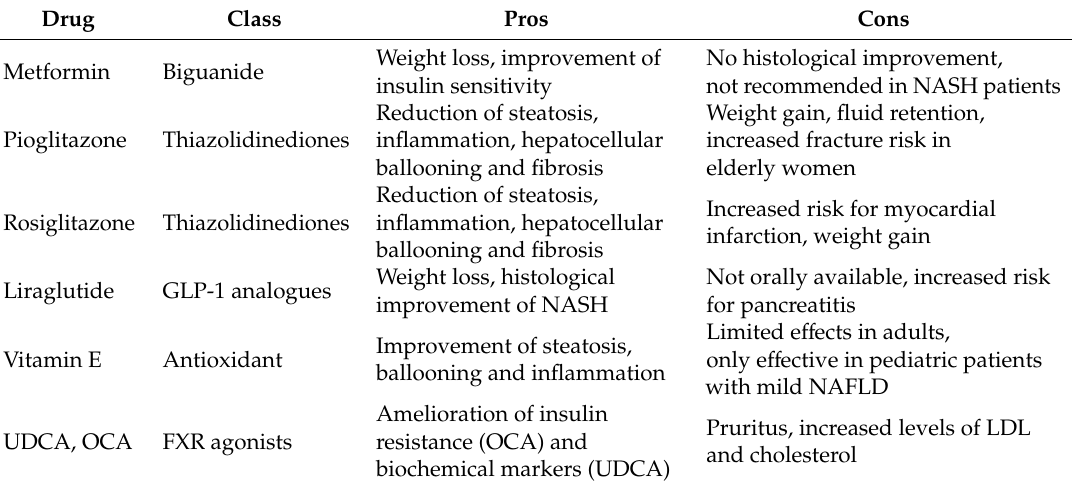
Table 1. Current management of nonalcoholic fatty liver disease (NAFLD) and NASH.